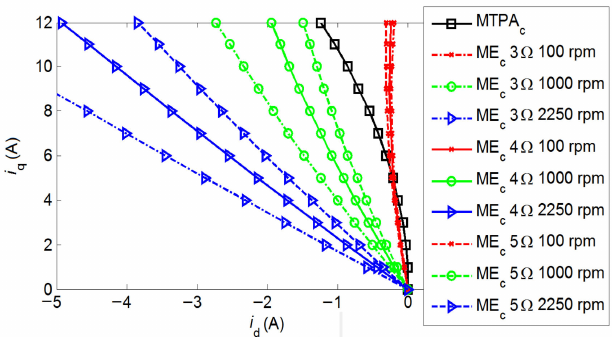
Figure 5. Calculated MTPA and ME characteristics at di ff erent rotor speeds and di ff erent constant values of the iron core resistance R c